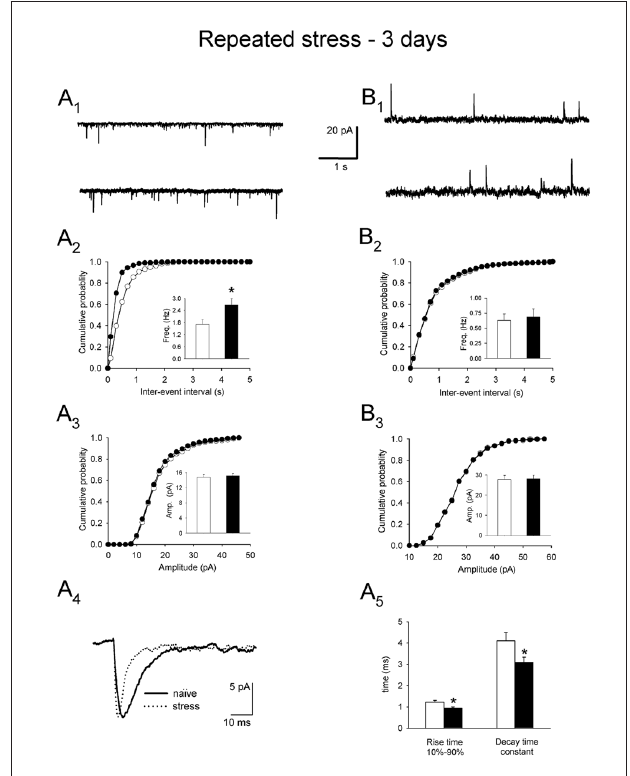
FIGURE 2 | Miniature postsynaptic currents and plasma corticosterone levels after restraint repeated over 3 days followed by a 24 h delay before measurements. (A 1 ) Representative raw recording of miniature excitatory postsynaptic currents (mEPSCs) in control preparation ( upper trace ) and in slice obtained after restraint ( lower trace ). (A 2 ,A 3 ) Cumulative probability plots of inter-event interval and amplitude distributions in control ( white circles/bars ) and stress ( black circles/bars ) conditions. Insets : comparison of the average values ( ± SEM). (A 4 ) Overlaid average mEPSCs recorded from representative PNCs from a control rat ( naïve ) and a rat subjected to repeated restraint ( stress ). (A 5 ) Comparison of the average ( ± SEM) rise time and decay time constant of mEPSCs in control ( white bars ) and stress ( black bars ) conditions. (B 1 ) Representative raw recording of mIPSCs in control ( upper trace ) and after restraint ( lower trace ). (B 2 ,B 3 ) Cumulative probability plots of inter-event interval and amplitude distributions in control ( white circles/bars ) and stress ( black circles/bars ) conditions. Insets : comparison of the average values ± SEM. ∗ Indicates p <